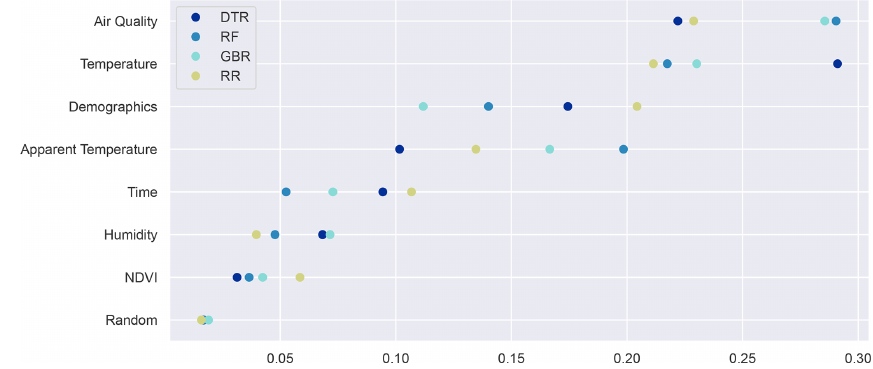
Figure 5. Aggregated feature importance for predicting MI for the general population. Related features have been grouped thematically. Larger values indicate higher importance, and per model the sum over all features equals 1.